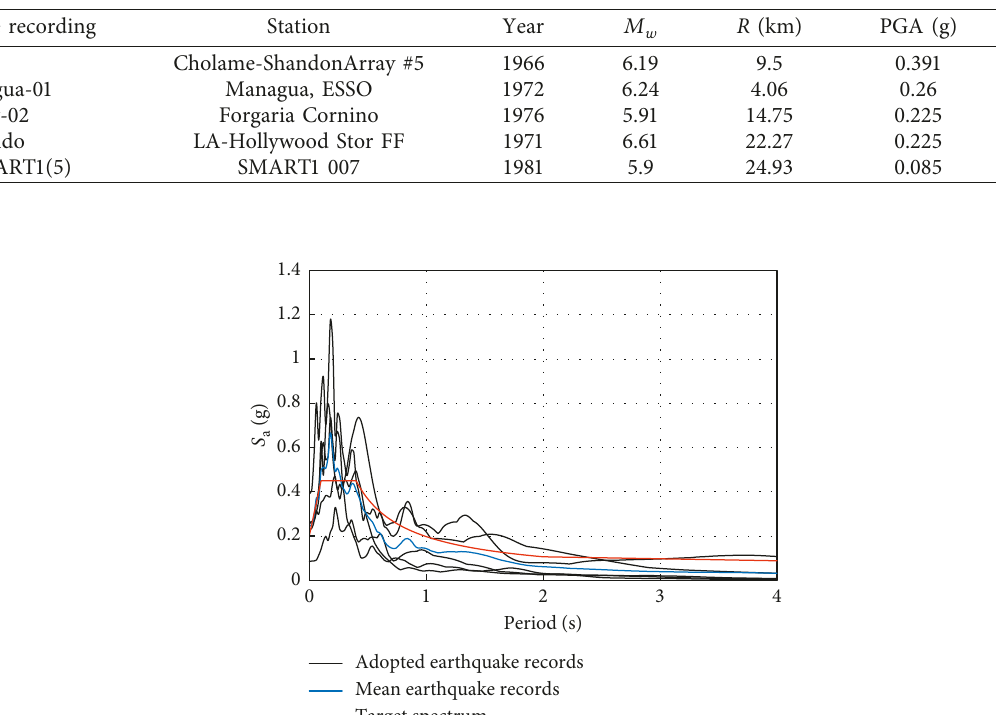
Table 5: List of earthquake records used for analysis.